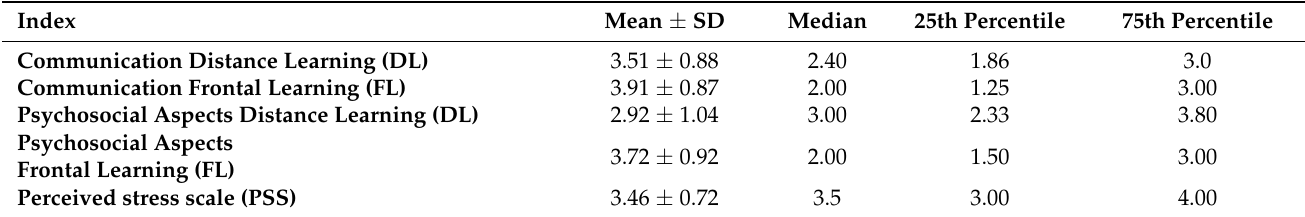
Table 3. Spread tendency and central tendency of the